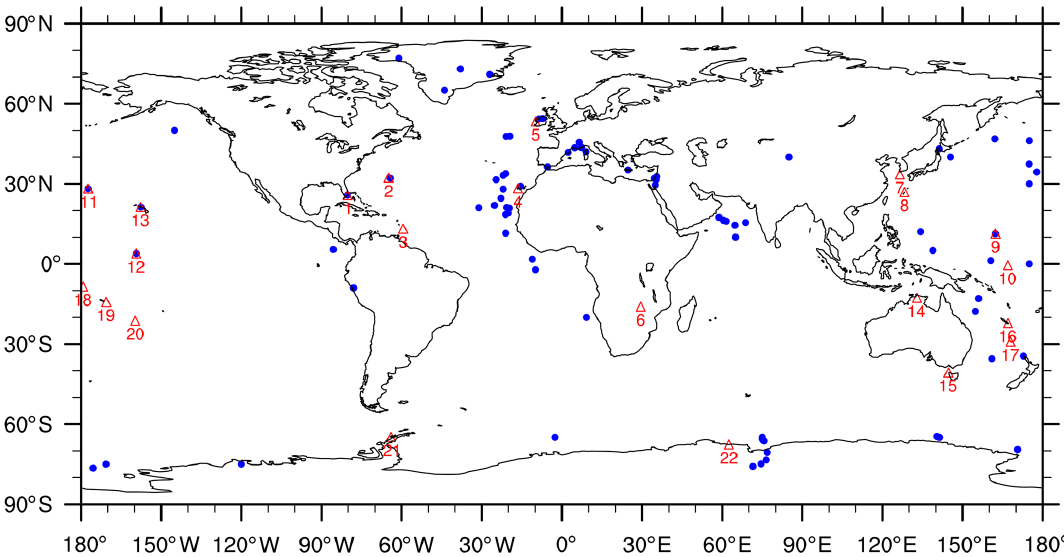
Figure 1. The distribution of observational stations used in this study: blue circles for dust deposition and red triangles for surface dust concentrations. The descriptions of all these stations can be found in Sect.